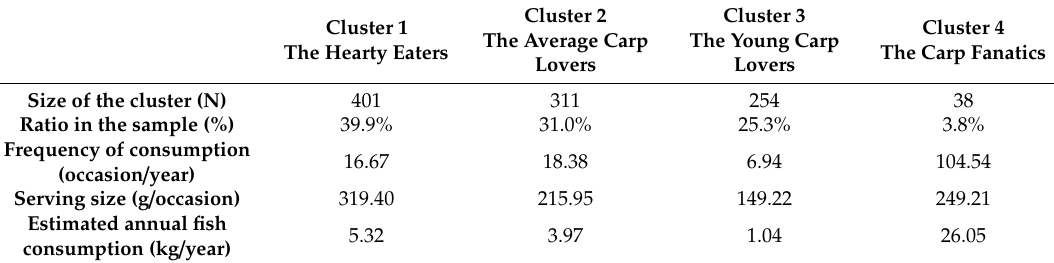
Table 2. Carp consumption characteristics of